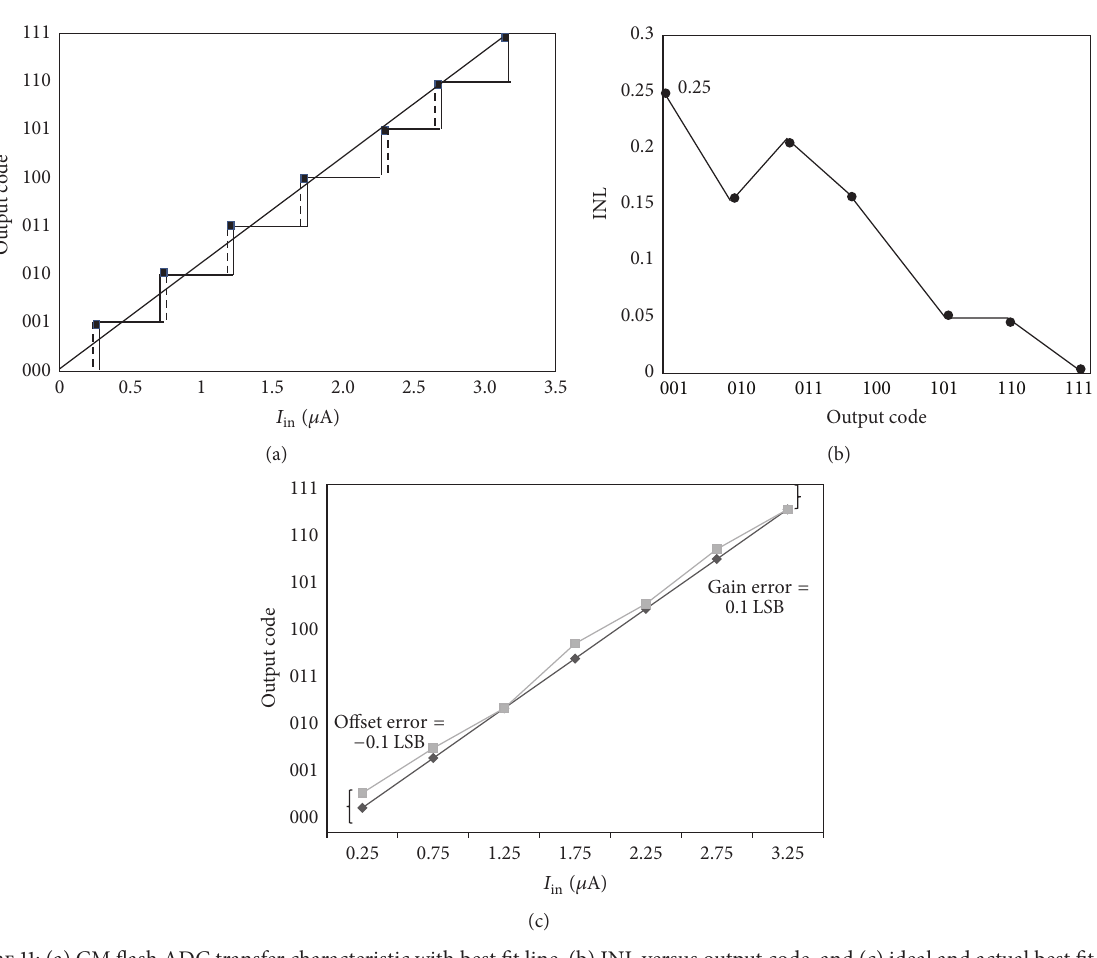
Figure 11: (a) CM flash ADC transfer characteristic with best fit line, (b) INL versus output code, and (c) ideal and actual best fit line.